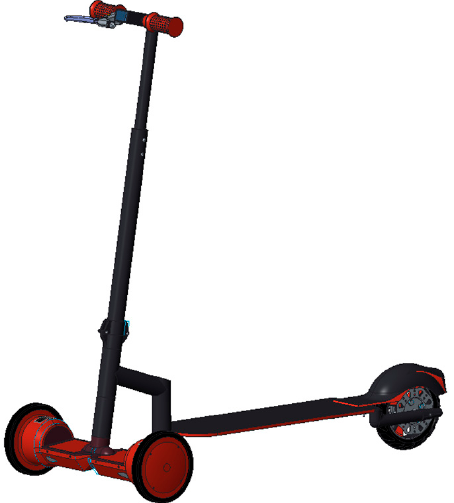
Figure 14. Final assembly.